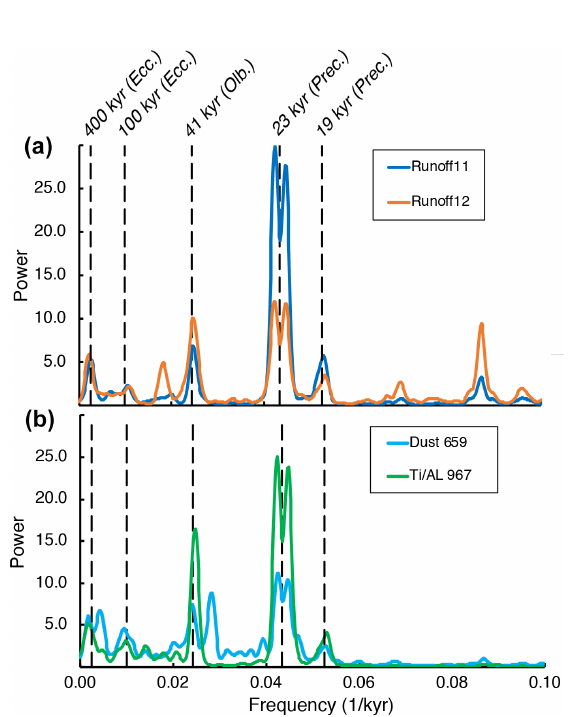
Figure 5. Normalised power spectra over the period 3.2 to 2.3Ma for (a) runoff of grid boxes 11 (blue) and 12 (orange), as well as (b) of Ti / Al from Site 967 (green) and dust from Site 659 (light blue). The Site 659 dust record is re-tuned to the LR04 benthic sta- ble isotope stack (Lisiecki and Raymo, 2005). Power spectra are created with AnalySeries (Paillard et al., 1996) using a Blackman– Tukey spectral analysis with a Parzen window and 90% lags. Ver- tical dashed lines indicate the dominant orbital periods of 400 and 100kyr (eccentricity), 41kyr (obliquity), and 23 and 19kyr (preces- sion).